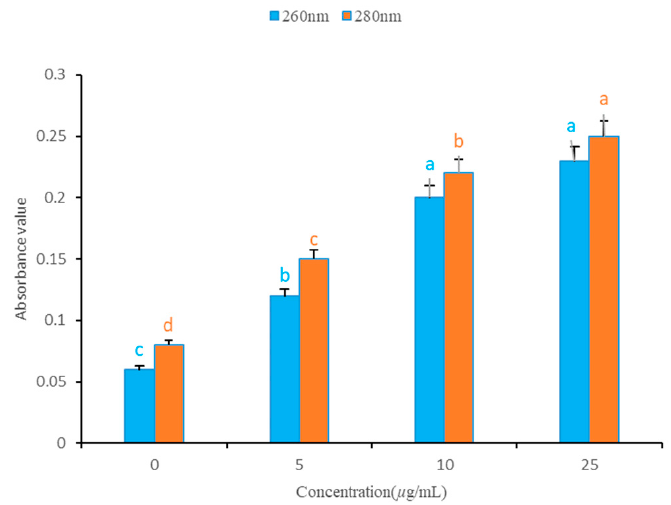
Figure 8. Release of cellular contents from S. sclerotiorum after treatment with W12 (Different letters indicate significant differences at p < 0.05 in the same group).